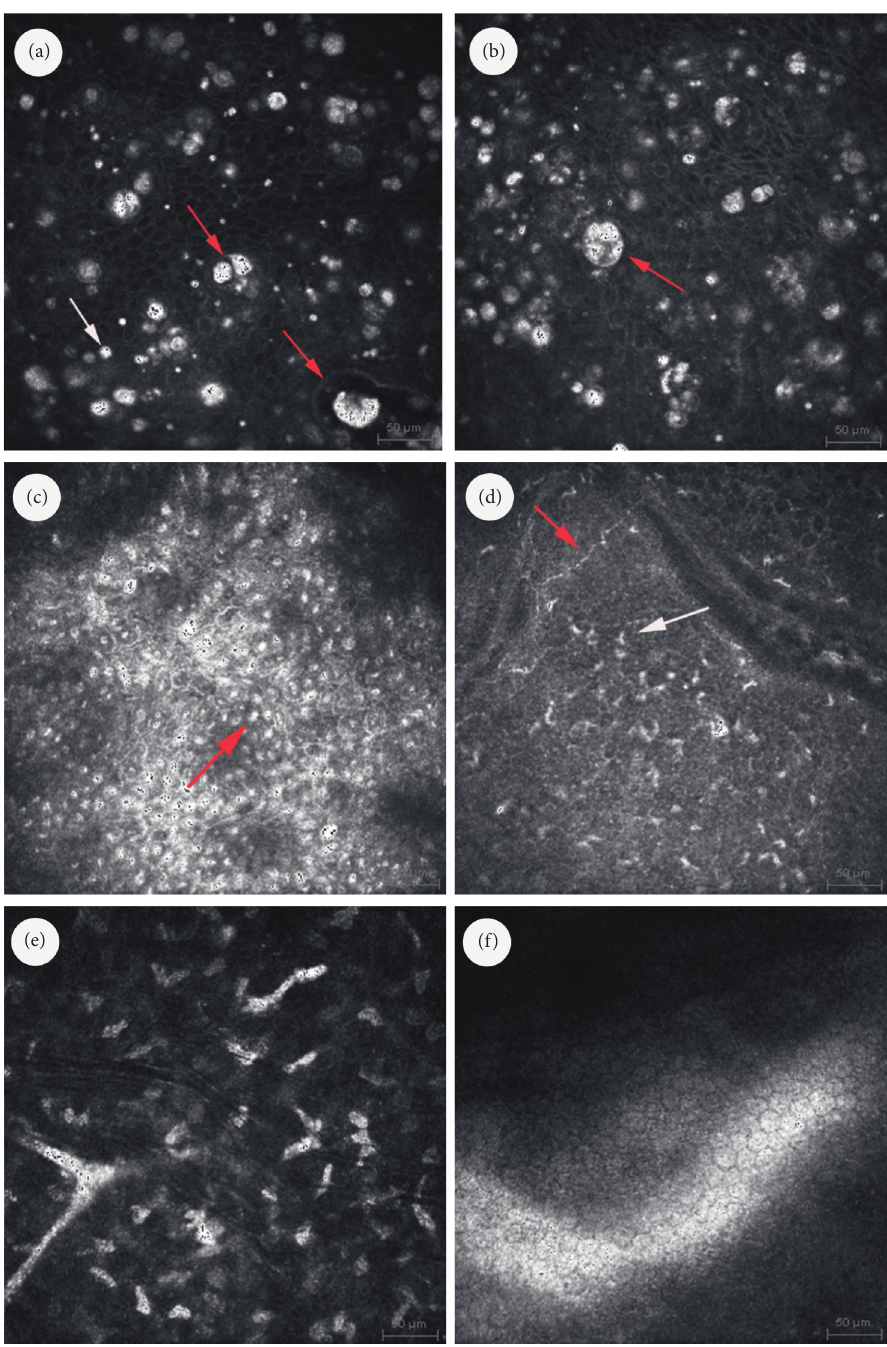
Figure 3: Confocal micrographs of the cornea. (a) IVCM micrograph of the superficial epithelium showing numerous small microcysts filled with highly reflective homogenous material (white arrow). Larger cysts filled with heterogenous hyporeflective and hyperreflective material (red arrows). (b) IVCM micrograph of the epithelium showing polymorphism along with disruption of a cytoarchitecture and disruption of the layered structure of the epithelium. Large cysts filled with heterogenous hyporeflective and hyperreflective material (red arrows). (c) IVCM image at the level of basal cells of corneal epithelium showing inflammatory changes. Brightly reflective and round structures visible at the centre of basal epithelial cells (red arrow). (d) IVCM micrograph of the Bowman layer showing increased density of Langerhans cells (white arrow) and activated keratocytes in the anterior stroma. Corneal nerve with normal morphology (red arrow). (e) IVCM image at the level of intermediate stroma showing activated keratocytes. (f) IVCM image of the endothelium with normal